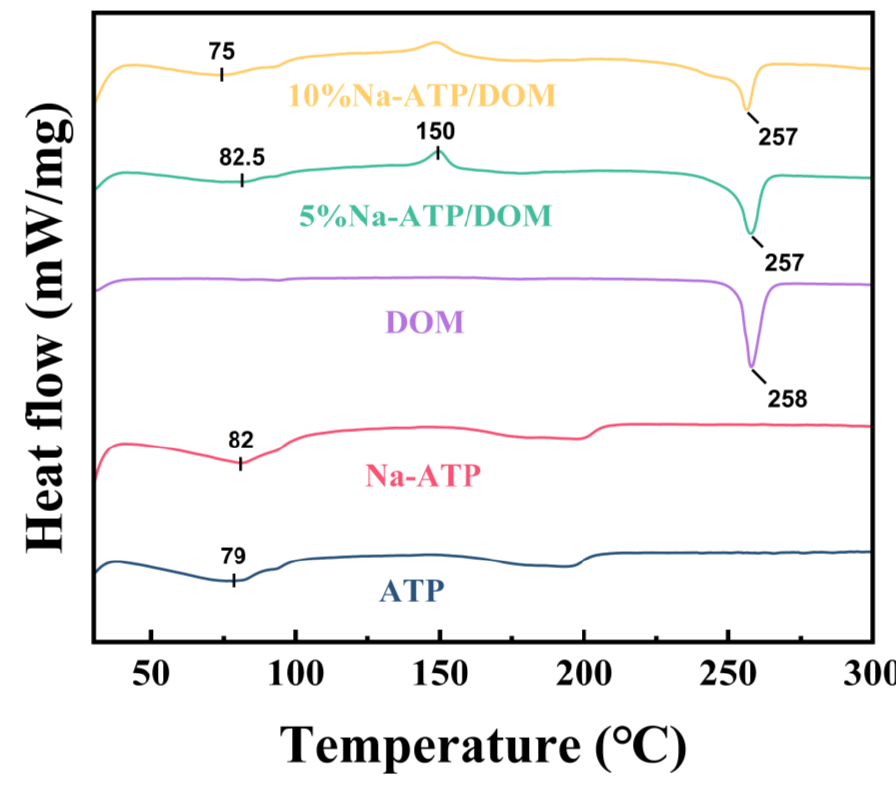
Figure 4. DSC curves of ATP, Na-ATP, DOM, 5% Na-ATP/DOM and 10% Na-ATP/DOM.